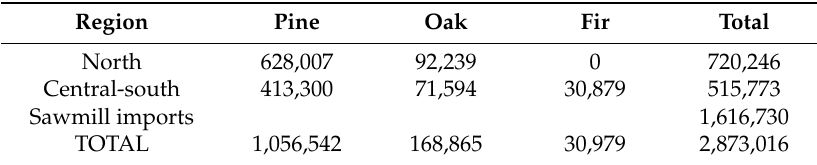
Region Pine Oak Fir Total North 628,007